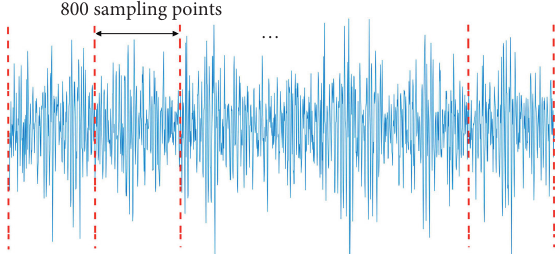
Figure 4: Segmentation of raw sample data of CWRU. Table 1: Description of CWRU dataset.